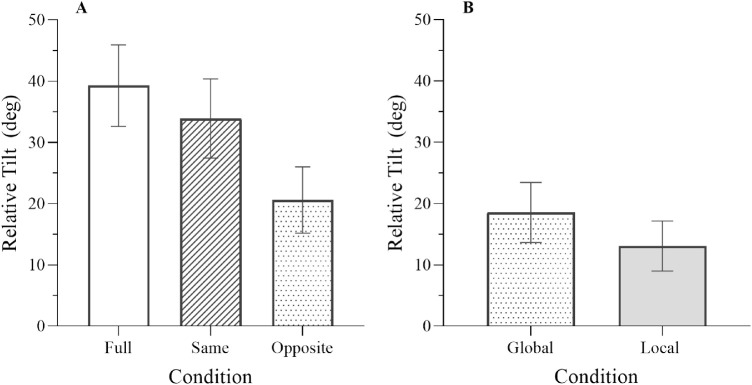
(A) Average relative tilt for the three conditions; full (unfilled), same (striped), and opposite (spotted). (B) Average local (filled) and global (spotted) relative tilts. Error bars are 95% confidence intervals.